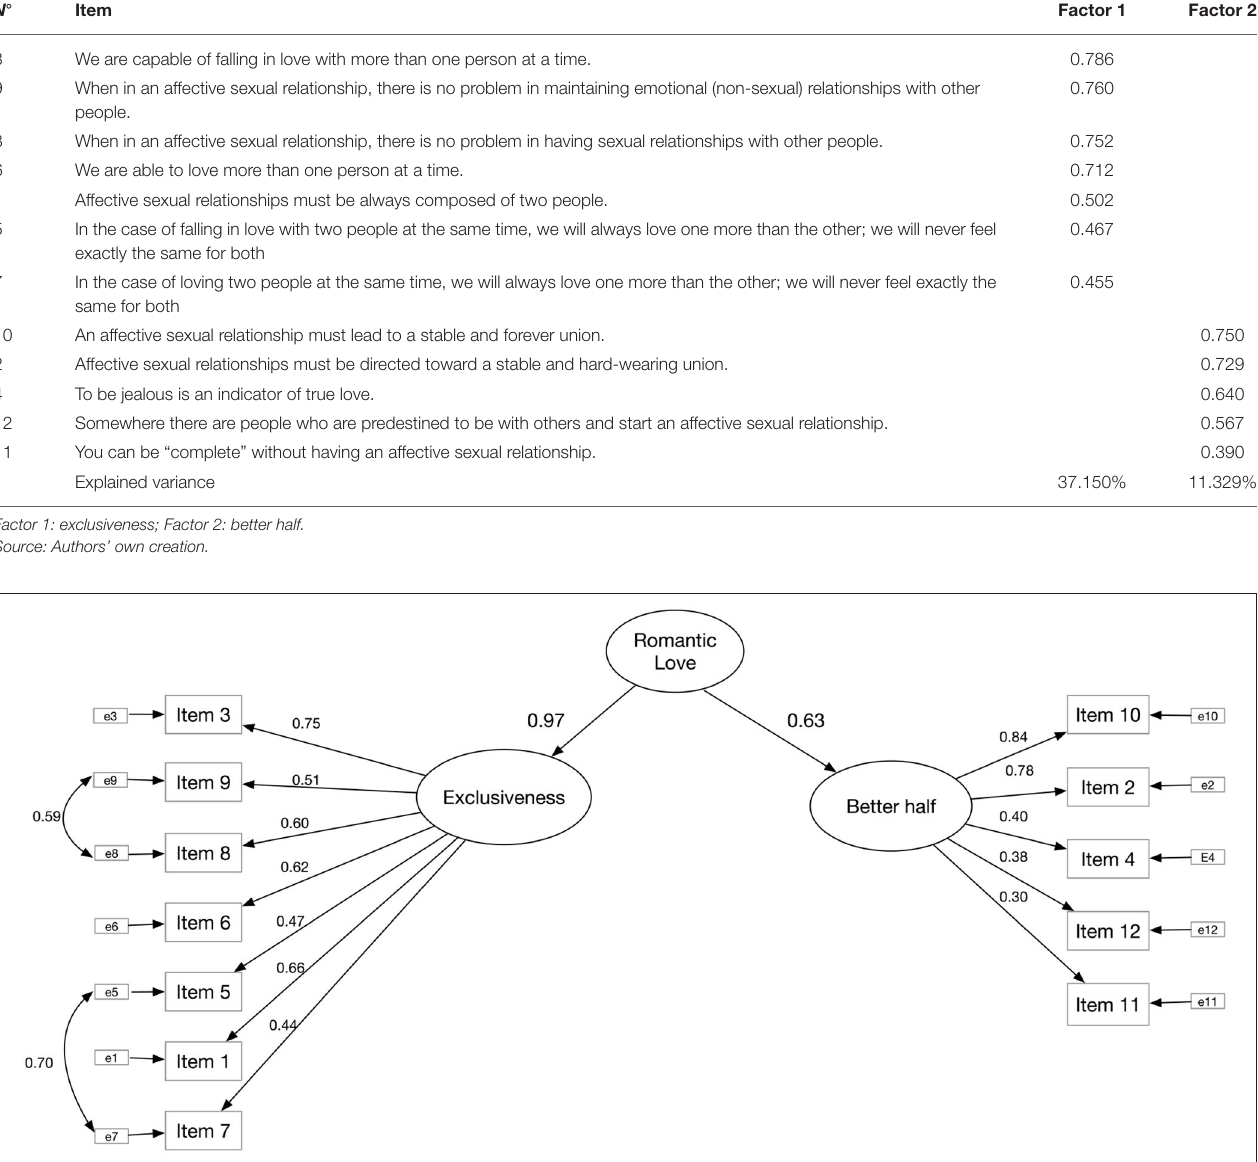
heterosexual people present more myths than those who define themselves as bisexual (mean difference = 0.38, SE = 0.05, p < 0.001, d = 0.51) and those who ascribe to the category “other” (mean difference = 0.49, SE = 0.10, p < 0.001, d = 0.64). In addition, the homosexual group presents higher scores in this factor, with respect to the bisexual group (mean difference = 0.36, SE = 0.08, p < 0.001, d = 0.46) and to “other” (mean difference = 0.47, SE = 0.12, p < 0.001, d =